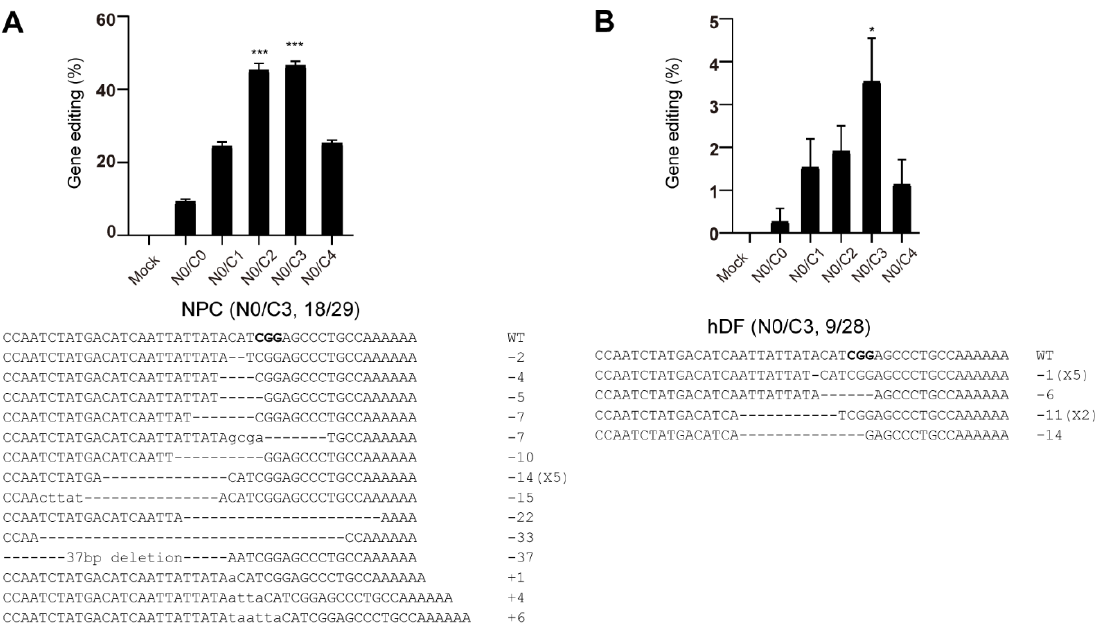
Figure 5. Genome editing of hNPCs ( A ) and hDFs ( B ) using multi-NLS SpCas9 proteins. The cells are nucleofected with 30 µ g SpCas9 proteins and 30 µ g CCR5 sgRNA. The editing efficiencies are determined by T7E1 analysis and presented as mean ± SD ( n = 3 technical replicates). Representative Sanger sequencing results are shown. PAM sequence is highlighted in bold. The Sanger-sequenced clones containing modified CCR5 sites over the total sequenced clones are indicated as 18/29 and 9/28 respectively. The difference between N0/C1 and multi-NLS constructs is analyzed by two-tailed Student’s t test. *, p < 0.05; ***, p < 0.001. The difference between SpCas9 groups and mock group is determined using one-way analysis of variance (ANOVA) with Dunnett’s multiple comparisons test. In NPCs ( A ), all SpCas9 groups have P values of less than 0.001 in comparison with mock group. In Jukat cells ( B ), p = 0.975 for N0/C0, p < 0.05 for N0/C1 and N0/C2, p < 0.001 for N0/C3, p = 0.149 for N0/C4.